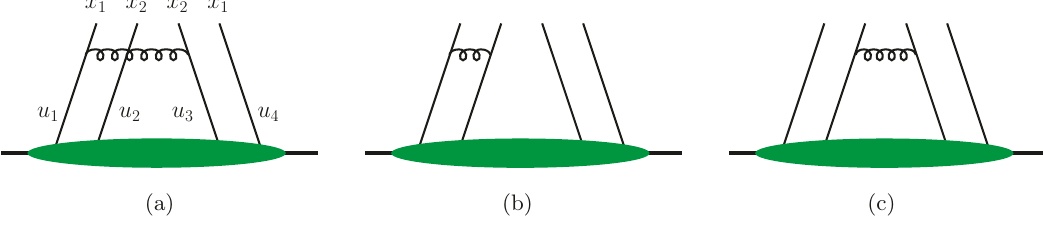
Figure 6 . Graphs for the short-distance behaviour of a DPD that involve a twist-four distribution. x i and u i denote longitudinal momentum